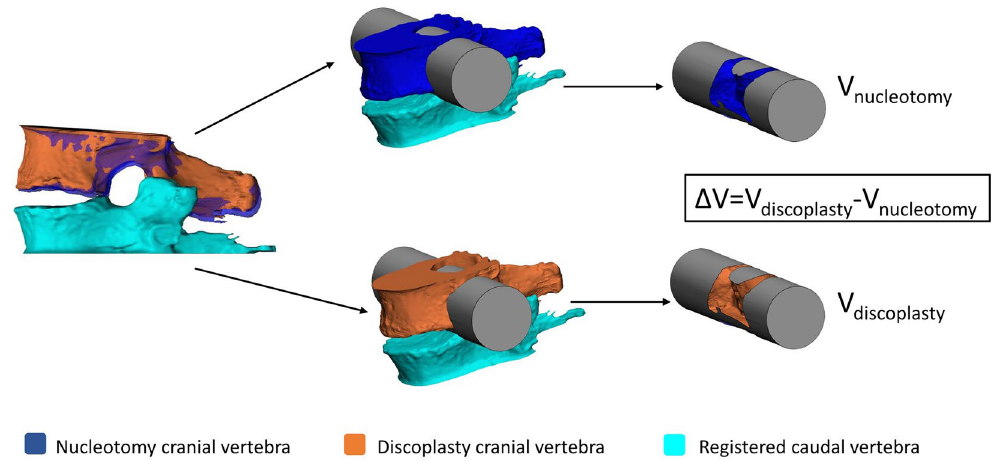
Figure 4. Foramen volumetric measurement method. Adapted from 5 under the CC BY license (http:// creat iveco mmons. org/ licen ses/ by/4.